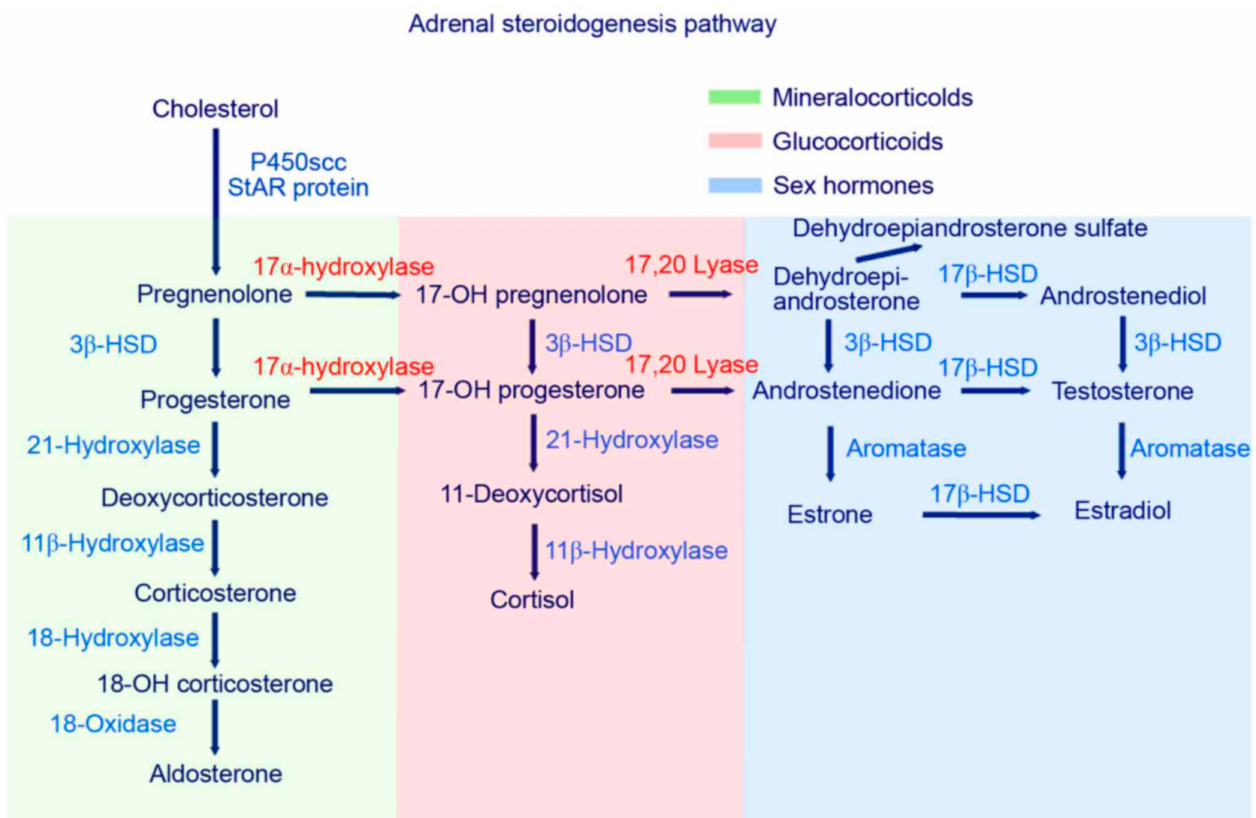
Figure 1. Steroid hormone activity—higher 17, 20-lyase activity should be indicated by higher levels of DHEA, DHEA-S and androstenedione. One step further, higher levels of androstenediol and testosterone in line with increased 17B-HSD and 3B-HSD are indicative of a general hyperandrogenism in autism